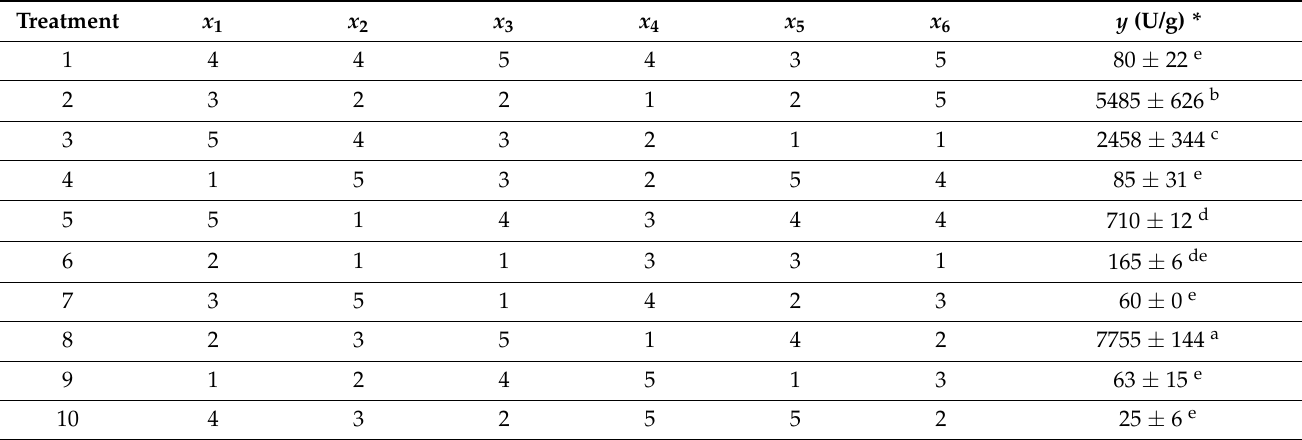
* Numbers in parentheses represent the coded levels used in the regression analysis. Table 2. Production of the LipMatCCR11-CLEAs according to uniform design U 10 (5 6